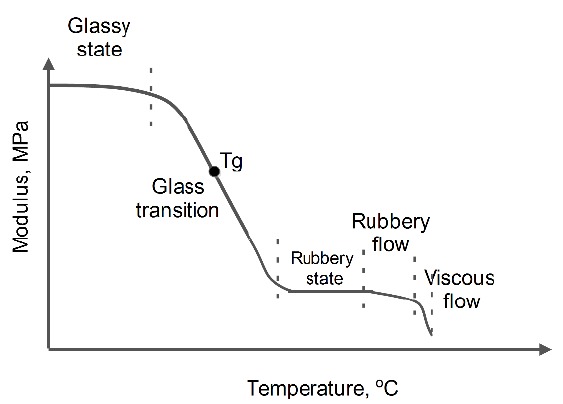
Figure 1. Variation of polymers state with temperature.